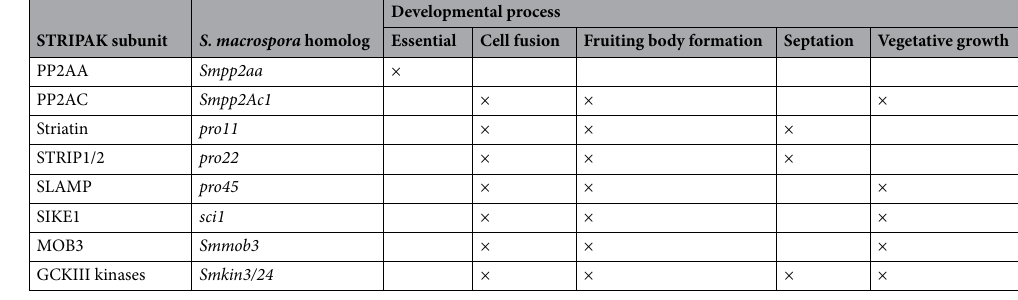
Table 1. List of STRIPAK subunit homologs in S. macrospora and their developmental role. Deletion of essential genes is lethal. Modified after 13 .